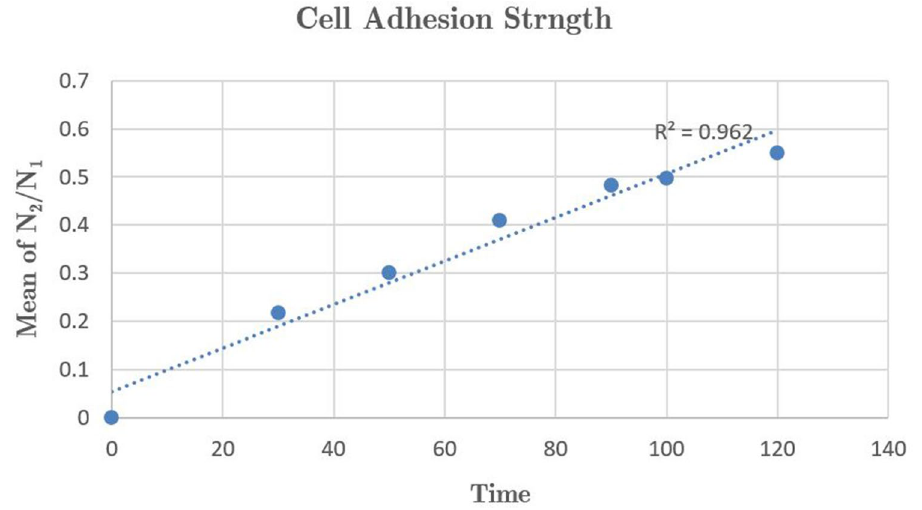
Figure 11. When the cells were exposed to plasma, the ratio of doublet (N 2 ) to singlet (N 1 )